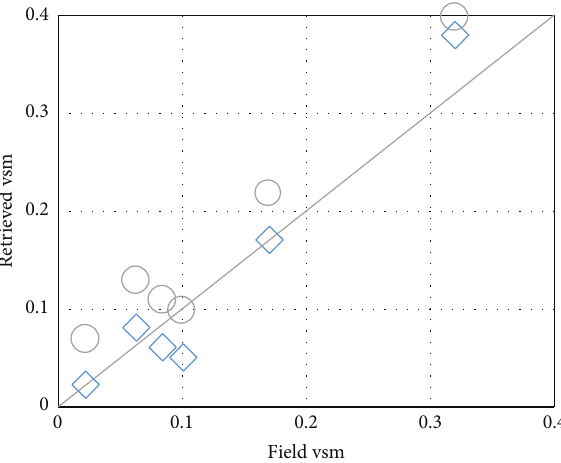
Figure7:Thescatterplotbetweenfieldandretrievedvolumetricsoil moisture(vsm).( ⃝ : 𝑄 𝑝 model, ◊ :discretemodeland 𝑄 𝑝